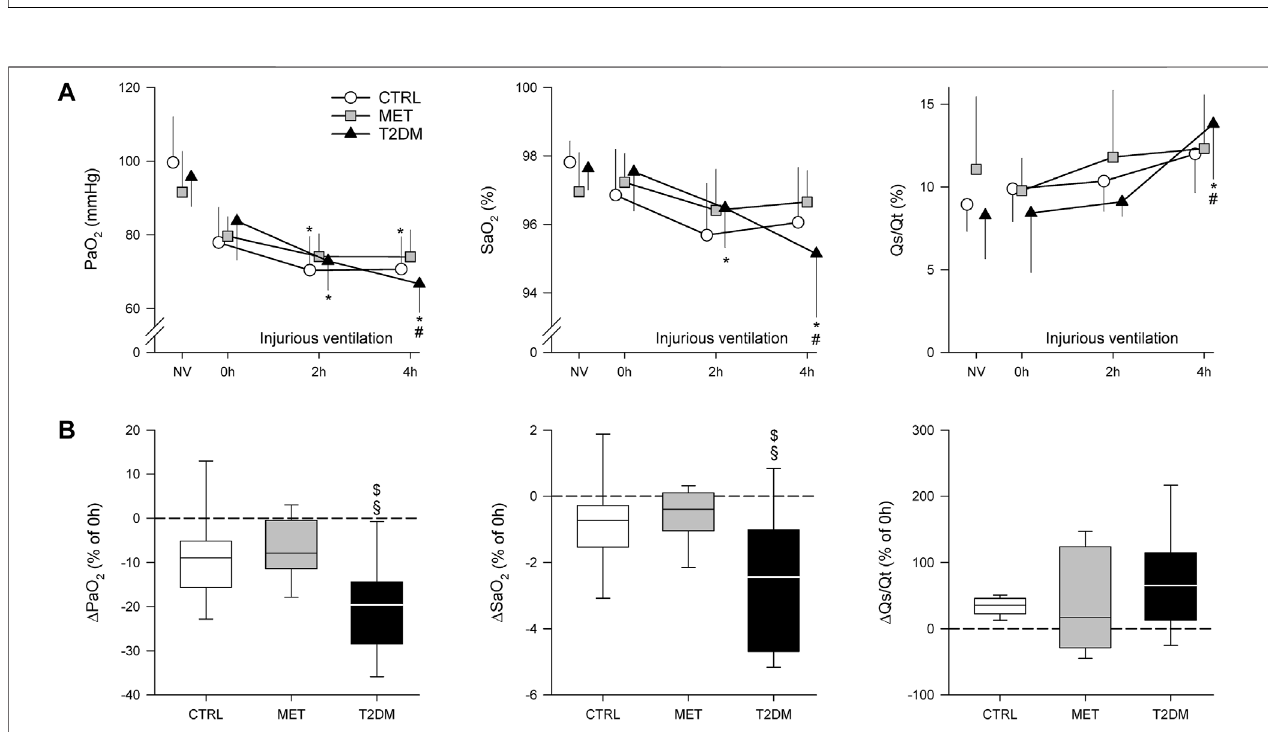
FIGURE 3 | Partial oxygen pressure (PaO 2 ) and oxygen saturation (SaO 2 ) of the arterial blood and the intrapulmonary shunt fraction (Qs/Qt) obtained during volume-controlled ventilation withphysiologicalparameters(NV) andinjuriousventilation incontrolrats(CTRL),inratswithmetformin-treated type2diabetes (MET),and in rats with untreated type 2 diabetes (T2DM). (A) : Absolute changes in mean values ± standard deviation (SD). (B) : Changes after 4 h of injurious ventilation values relative to the values obtained at 0 h. * p < 0.05 vs . 0 h; # p < 0.05 vs . 2 h; $ p < 0.05 vs . CTRL; § p < 0.05 vs . MET.